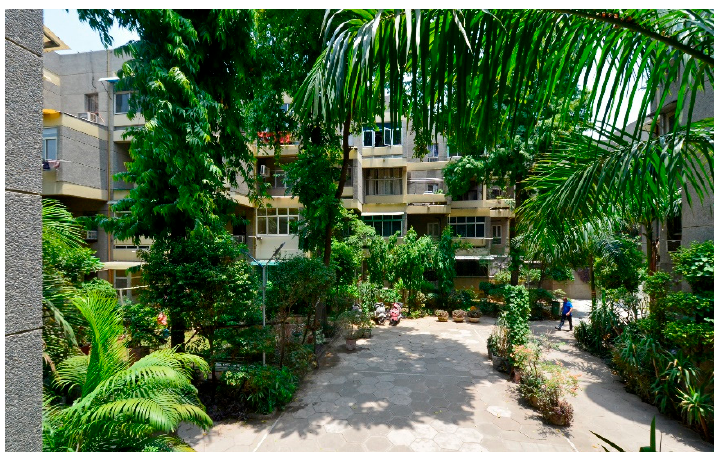
Figure 5. Vegetation cover along the pedestrian streets in Yamuna Apartments (Photo: Author).